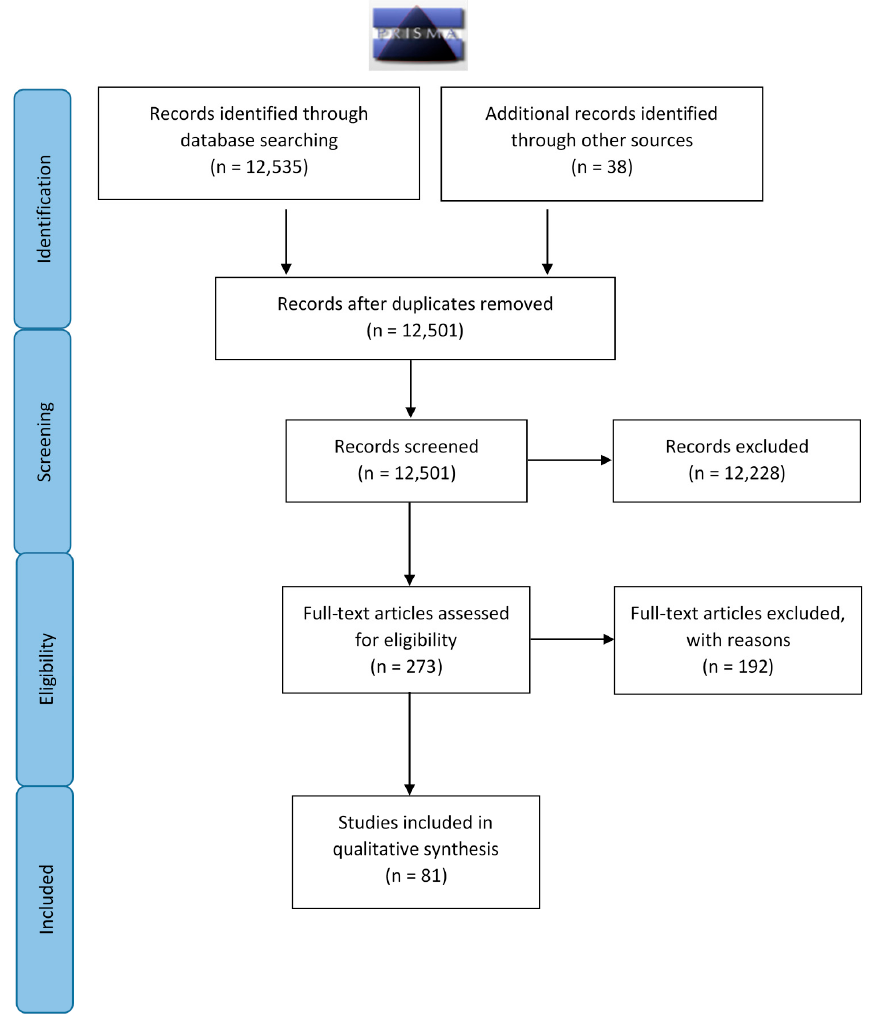
Figure 1. PRISMA Flow Diagram (Moher et al. 2009).